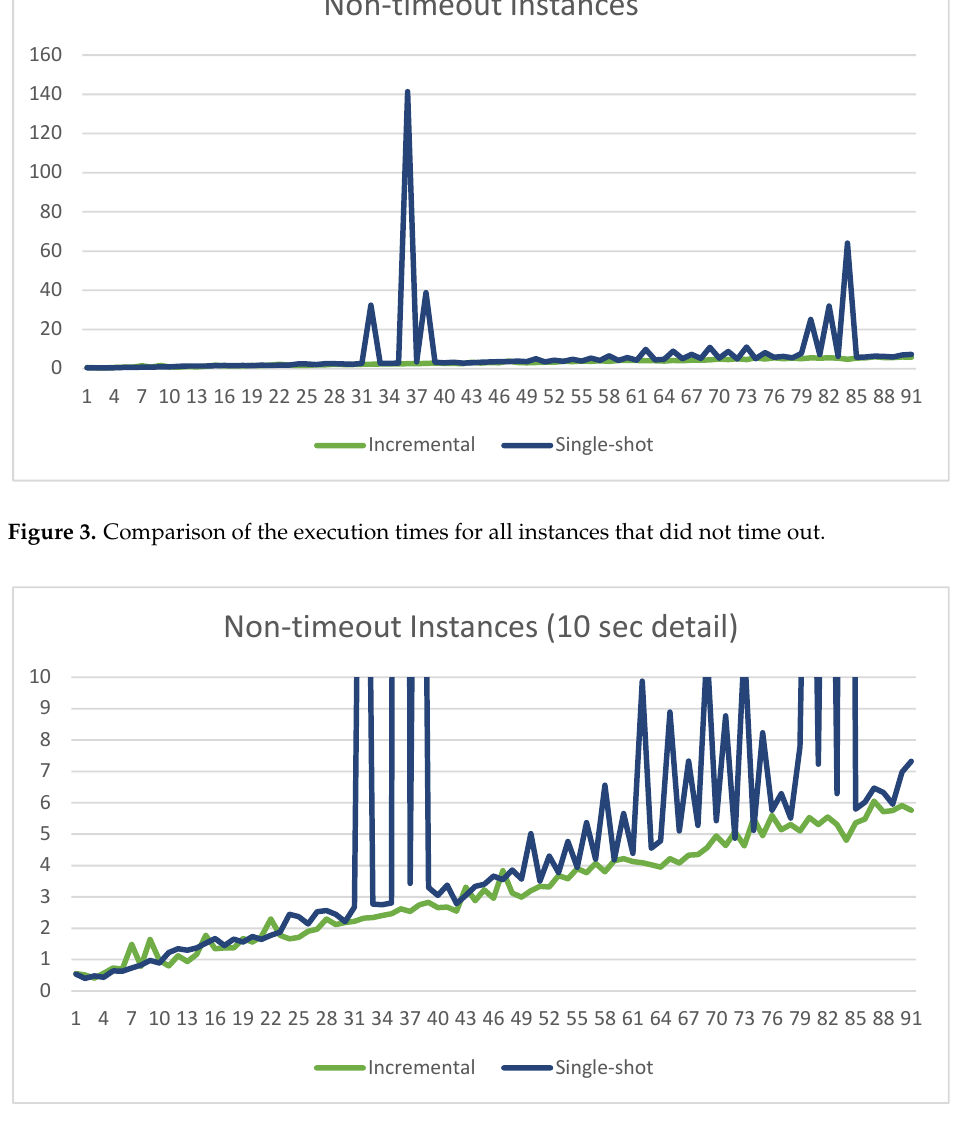
Figure 4. Comparison of the execution times for all instances that did not time out, 0–10 s